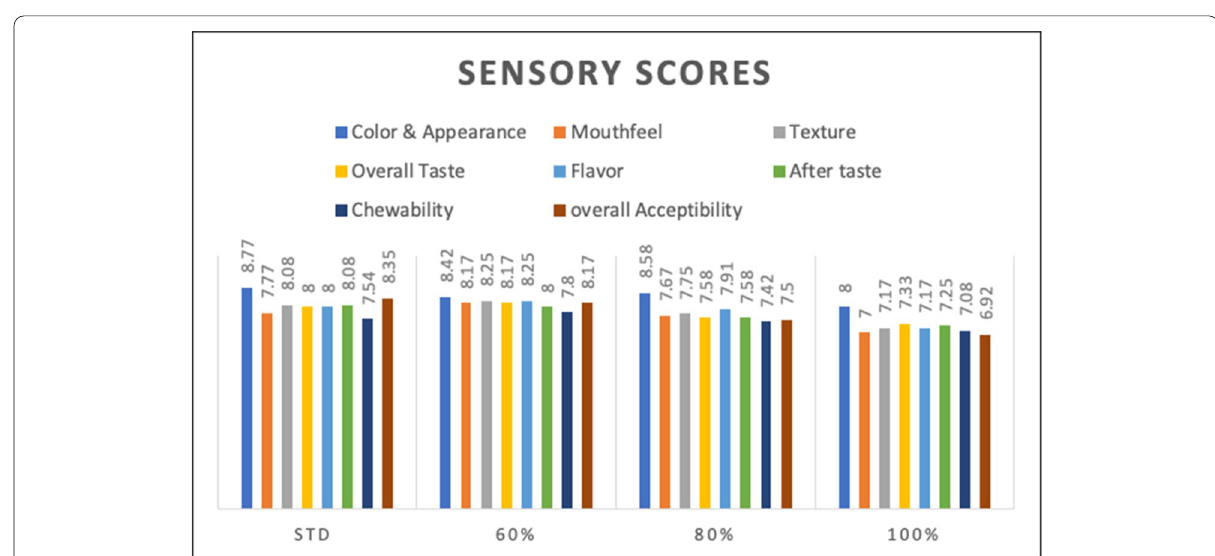
NS – the difference between the mean values within the columns is not significant Mean values represent the average of the scores in triplicate Level of significance in increasing order – (* p < 0.05, ** p <